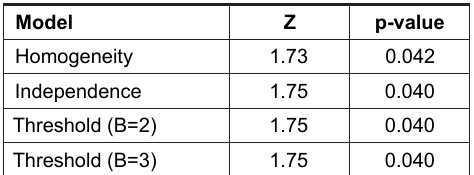
Table 35. Tests for randomness of collar distri- bution for the Cape Bathurst 2015 post calving